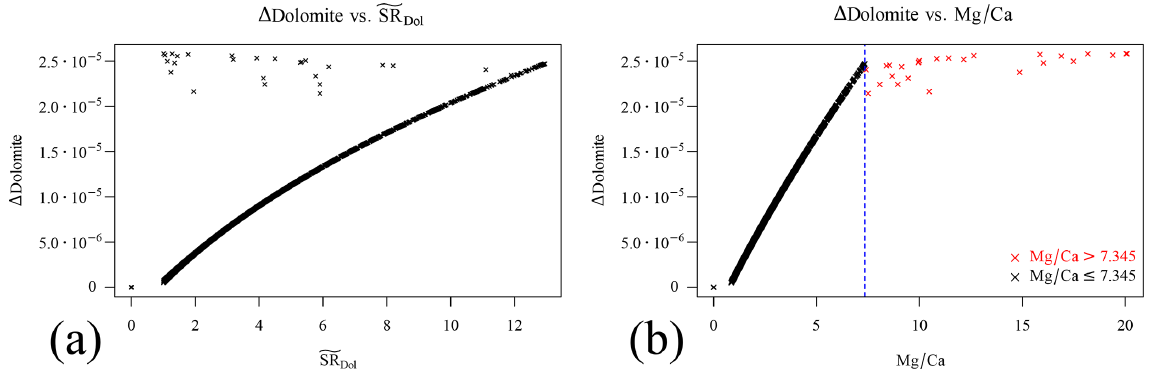
Figure 8. Precipitation of dolomite in the presence of calcite. (a) The relationship between (cid:49) dolomite and its saturation ratio is not surjective. (b) The Mg / Ca ratio perfectly discriminates two distinct regions in parameter space.